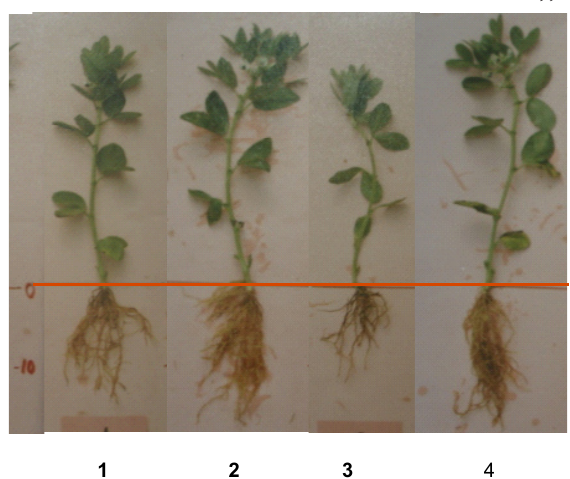
Fig. 1. Effect of micronutrients spraying on the growth of faba bean plant grown under salinity treatment. 1=Control (with- out NaCl and without micronutrient foliar spray); 2=Control + micronutrient foliar spray; 3=1000 ppm NaCl ( without mi-